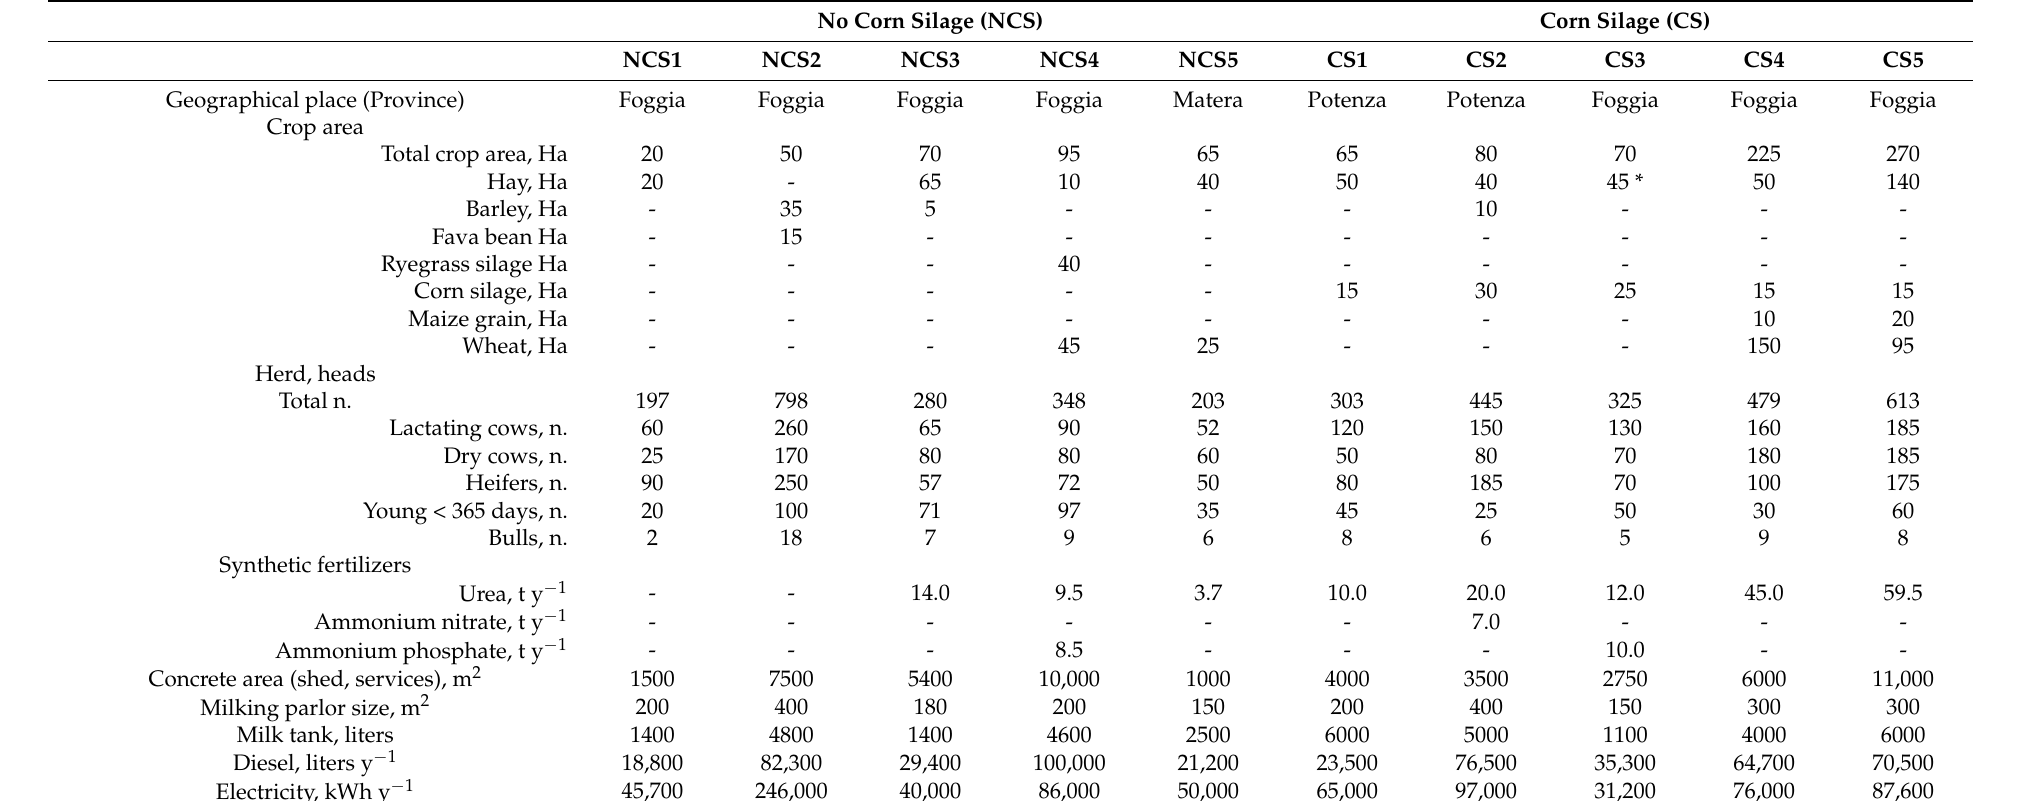
Table 1. Profiling of the farms of the two